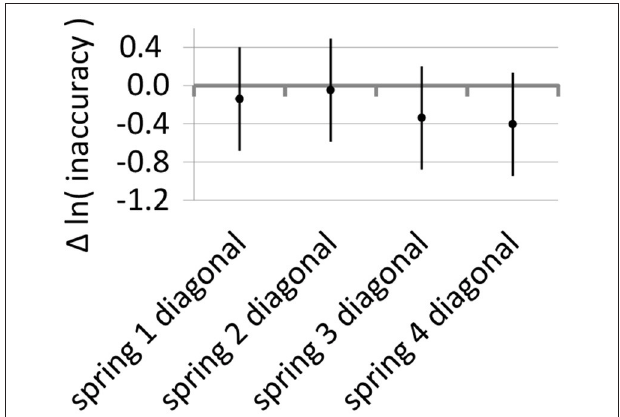
FIGURE 8 | Effect of variable stiffness on the inaccuracy of experts. The diagram shows the estimates and 95% confidence intervals of the differences between inaccuracy with diagonal-type variable-stiffness springs and with the rigid connection. Lower values are